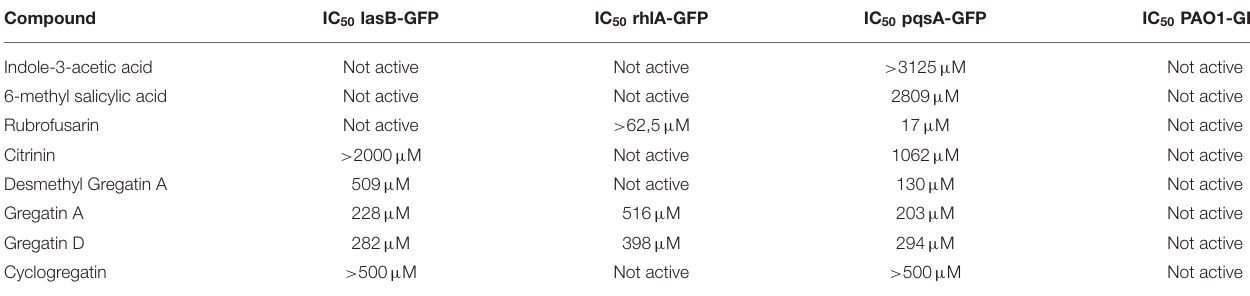
TABLE 3 | QS inhibitor activity of selected compounds in P. aeruginosa (PAO1) reporters. Compound